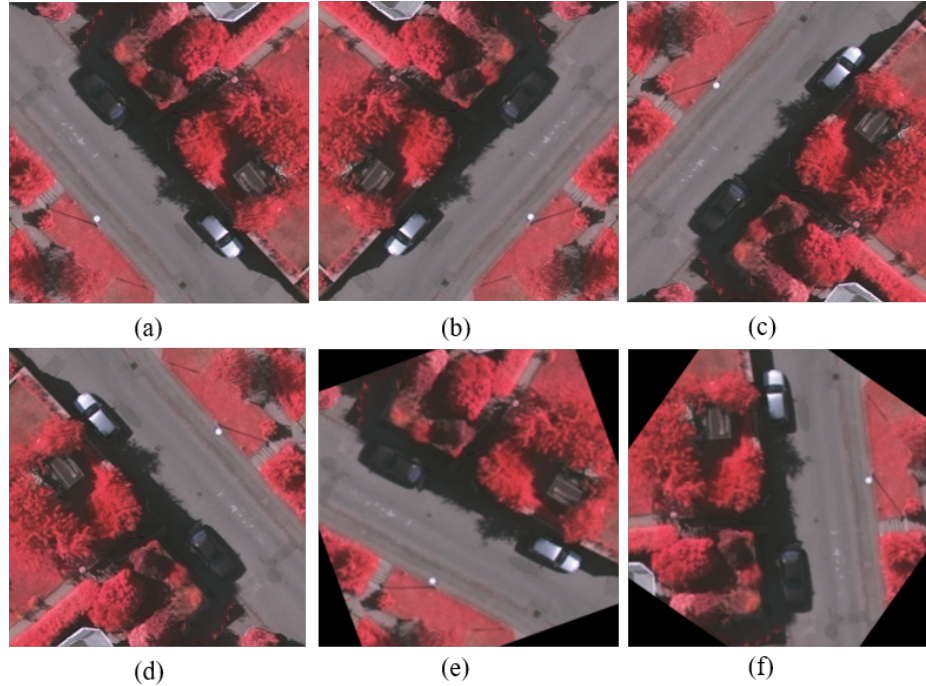
Figure 10. Examples of experimental dataset enhancements. ( a ) is the reference image, and ( b – f ) is examples of multiple enhanced operations based on